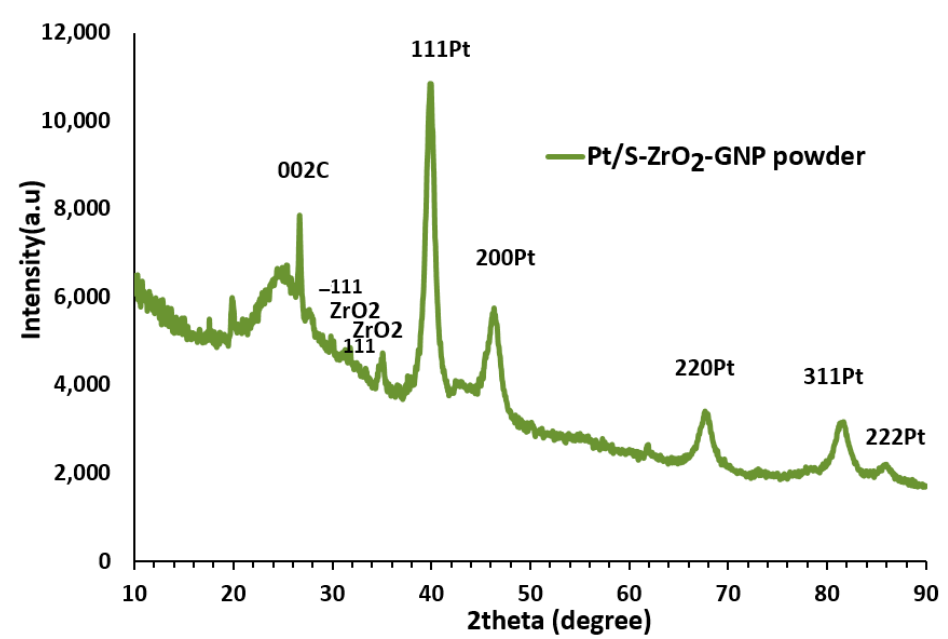
Figure 5. X-ray diffractograms of Pt/S-ZrO 2 -GNP electrocatalyst.